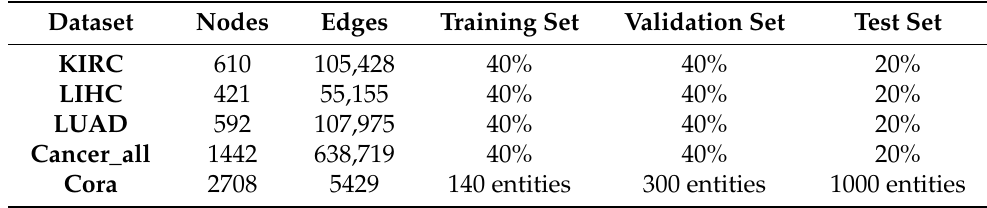
Table 4. Graph Information.